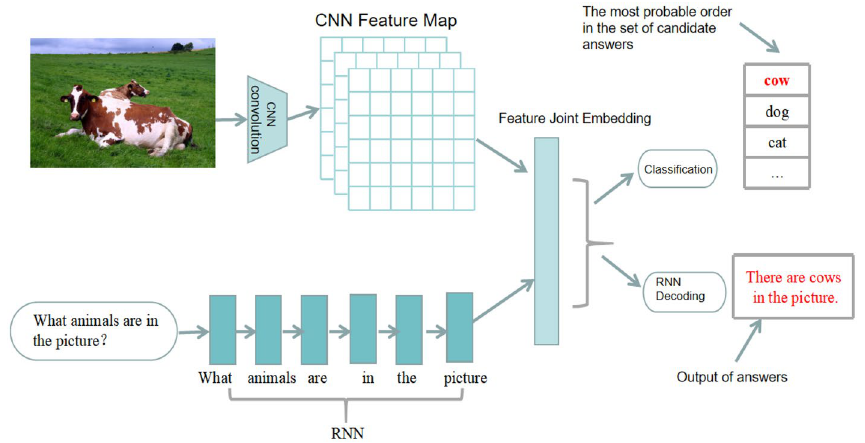
Figure 1. Overall framework of DMN-MA